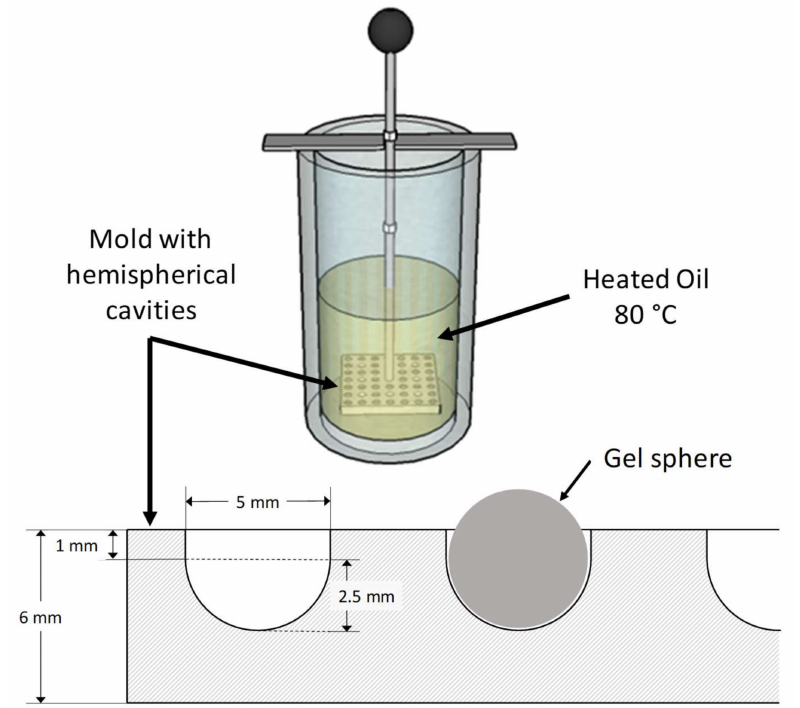
Figure 4. Oil bath and sectional drawing of mold for sample preparation of spherical protein gels with a diameter of 5